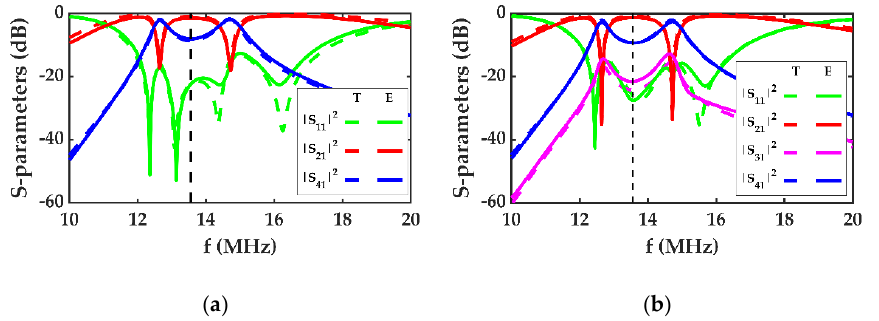
Figure 8. Experimental (solid) and theoretical (dashed) frequency dependence of S-parameters for double passband MI filter with resistive narrowband terminations with ω 0 = 13.56 MHz, Q = 180 , 𝑍 0𝑀 = 50Ω , and κ c = 0.3 . ( a ) No improved rejection; ( b ) improved rejection.